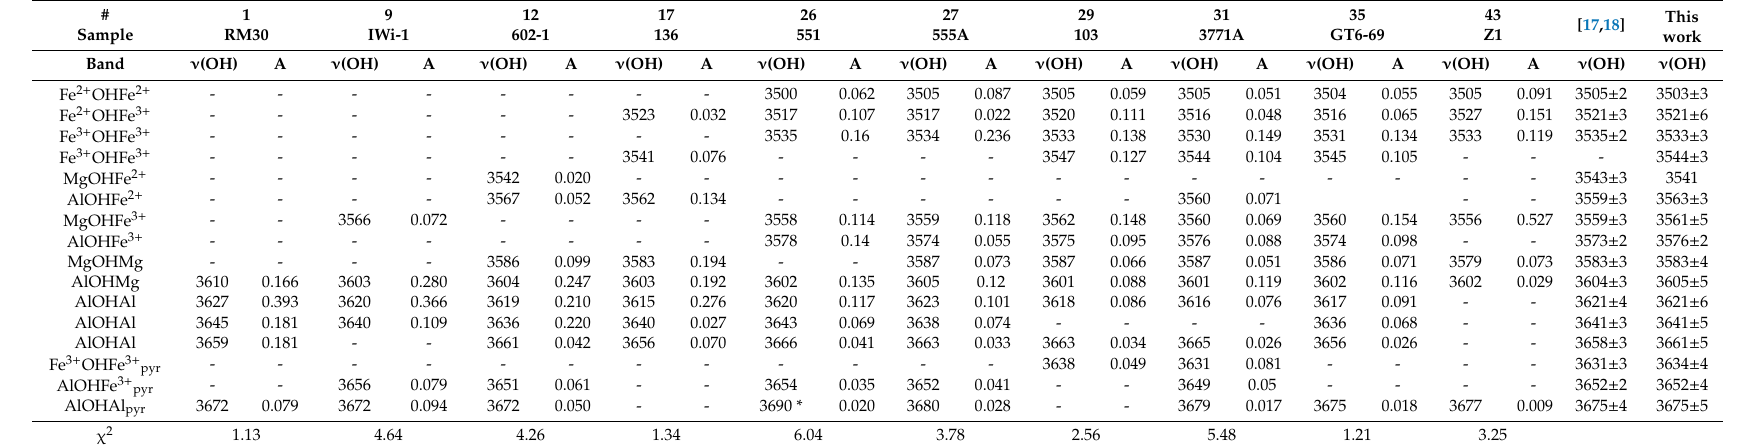
Table 5. Positions ν (OH), cm − 1 and relative integrated intensities I of OH stretching bands corresponding to specific OH-bonded cation pairs in the FTIR spectra of selected K-dioctahedral 1 M micas; χ 2 is the minimization function. (Sample numbers as in Tables